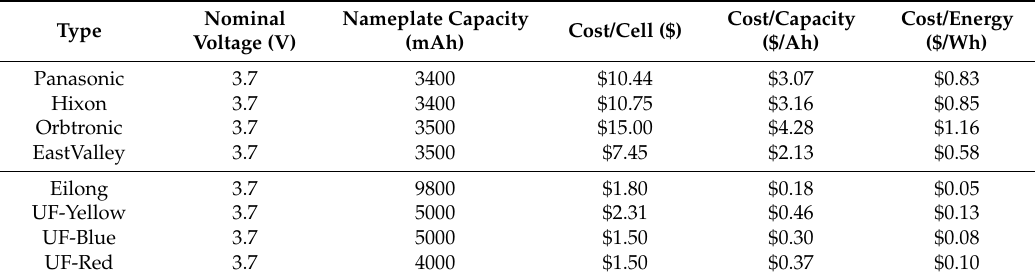
Table 4. Cost comparisons of cells based on published cell data and labeling.